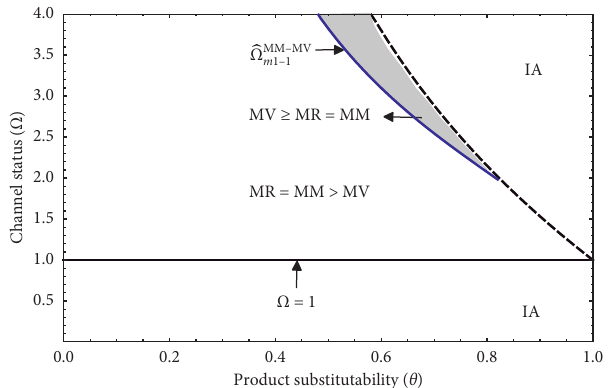
Figure 5: Comparison of manufacturer 1 profits under MS.